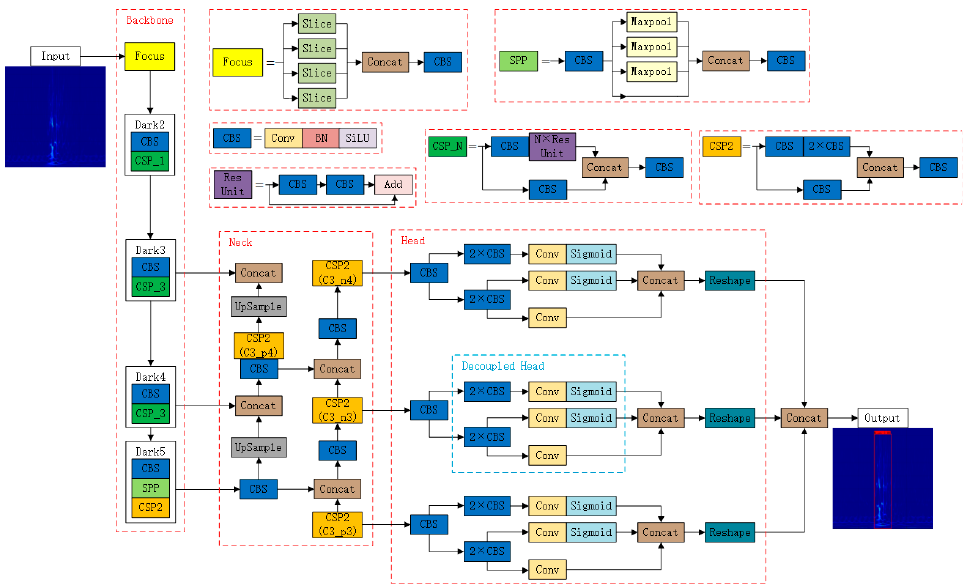
Figure 1. Spectrogram detection of wire breaks based on YOLOXs.